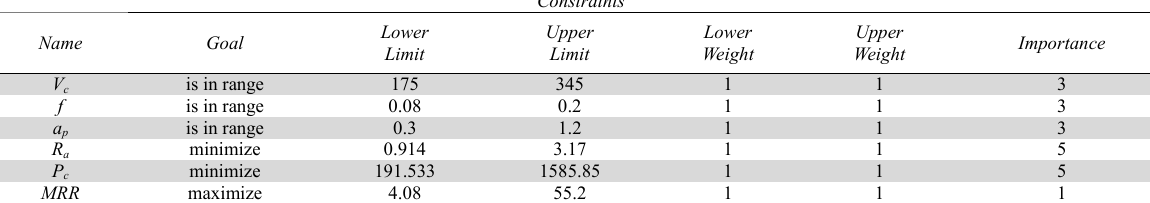
Goals and parameter ranges for optimization of cutting conditions